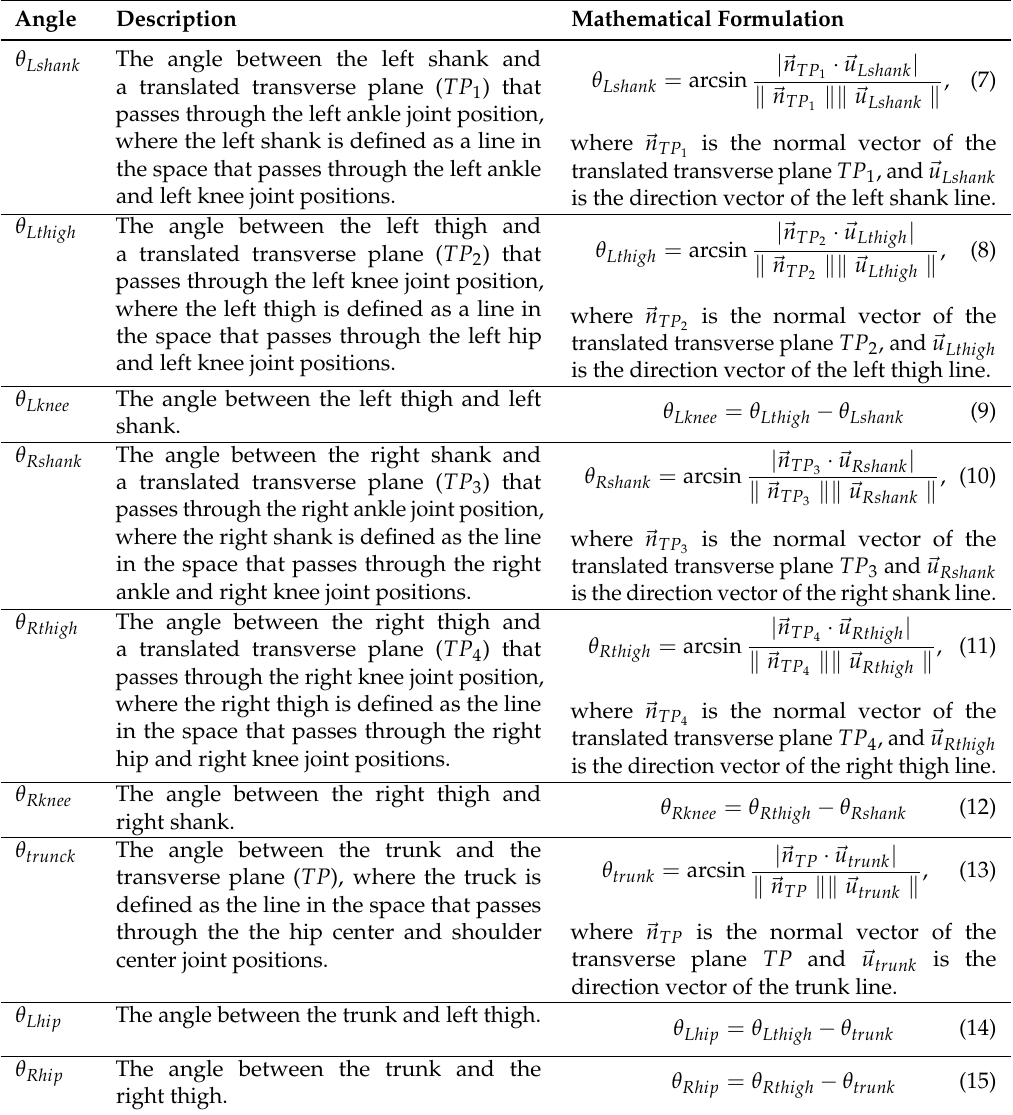
Table 2. The angle-based features employed in the pose